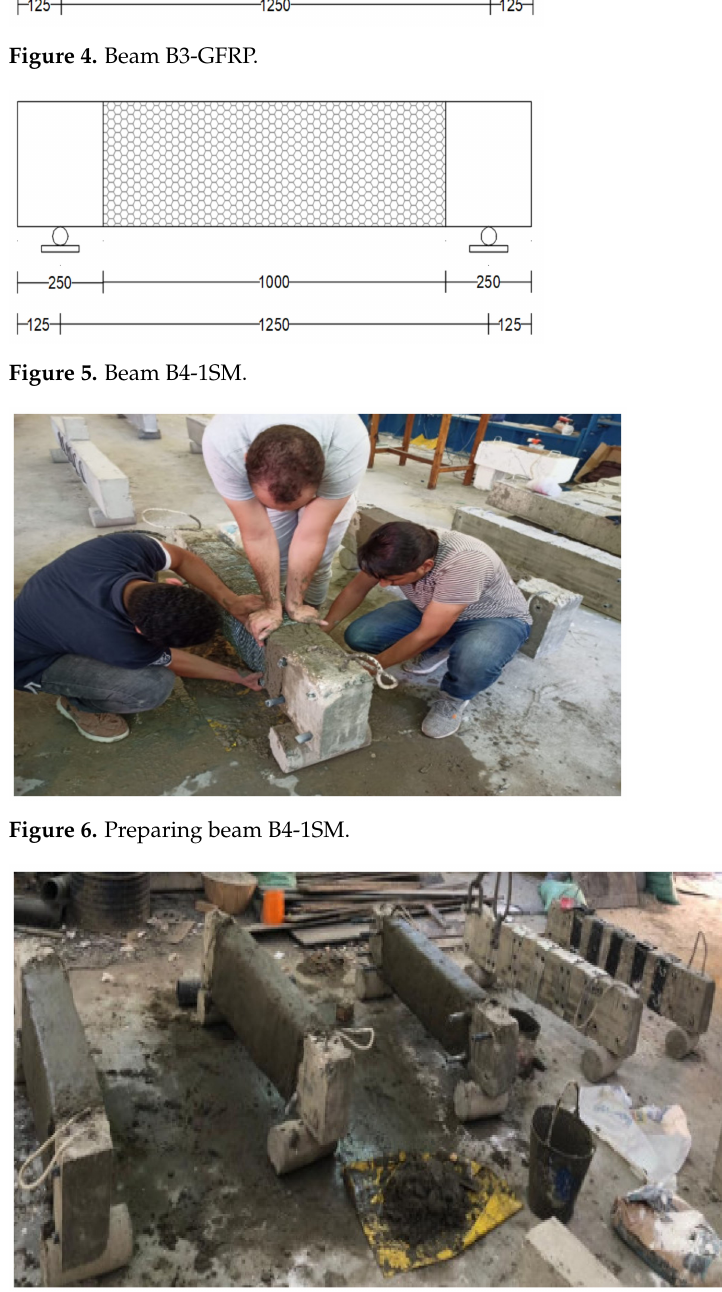
Figure 7. The strengthening beams before